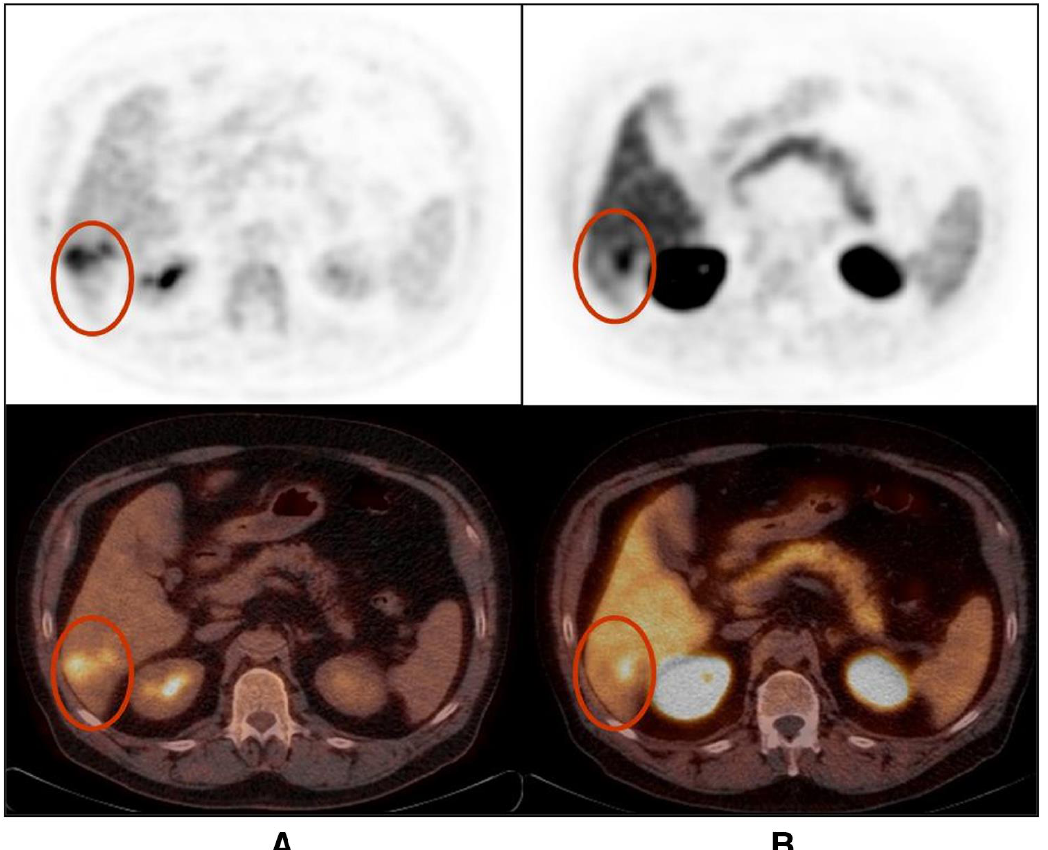
Figure 2. Poorly differentiated hepatocellular carcinoma shows partially congruent uptake of FDG ( A ) and FCH ( B ) (lesions shown in red circles). The FDG-positive areas appear photopeanic on FCH PET/CT (images reproduced with permission from [53] ).